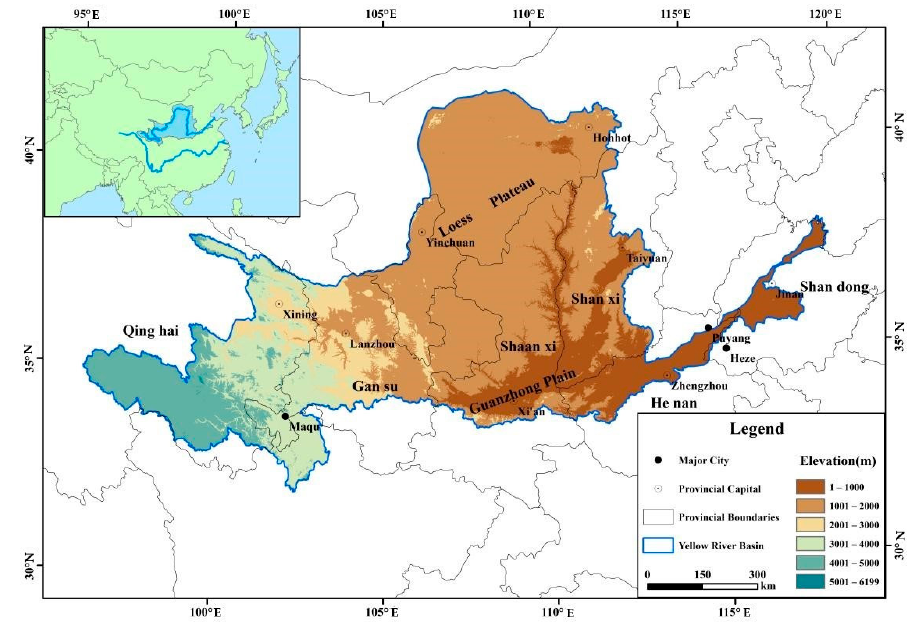
Figure 1. Location overview of the Yellow River Basin.